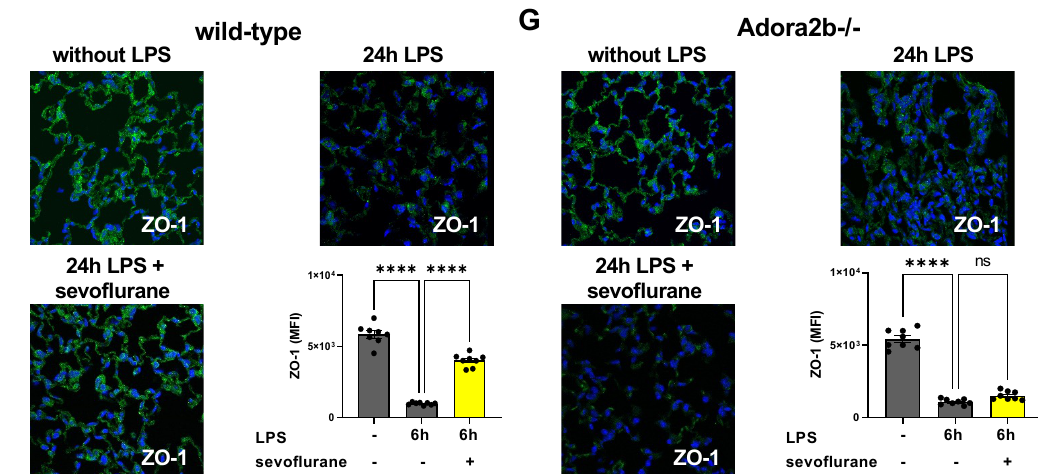
Figure 4. Impact of sevoflurane on microvascular permeability of wild-type and adenosine A2B receptor − / − (Adora2b − / − ) animals. ( A ) Six and 24 h after lipopolysaccharide (LPS) stimulation and sevoflurane treatment, we evaluated the protein extravasation, and the pulmonary tissue thickness by immunohistochemistry. ( B ) The impact of sevoflurane on the LPS-induced Evans blue extravasation in wild-type, and ( C ) Adora2b − / − mice ( n = 6–8). ( D ) Histological slides of the pulmonary tissue with or without LPS exposure of wild-type and ( E ) Adora2b − / − animals ( n = 7–8). Evaluation of the septal thickness at indicated conditions. ( F ) The LPS-related expression of the tight junction protein zonula occludin-1 (ZO-1; green) in the lung tissue of wild-type and ( G ) Adora2b − / − mice was determined by immunofluorescence (mean fluorescence intensity; MFI) (original magnification × 63; one representative image of three independent experiments is shown; n = 3). DAPI (blue) was used as a nuclear marker. Fluorescence intensities of ZO-1 with or without LPS exposure were measured by using ImageJ ( n = 6–8). Statistical analyses were performed by one-way ANOVA + Bonferroni correction. Data are presented as mean ± SEM; ns = not significant; *** p < 0.001; **** p <